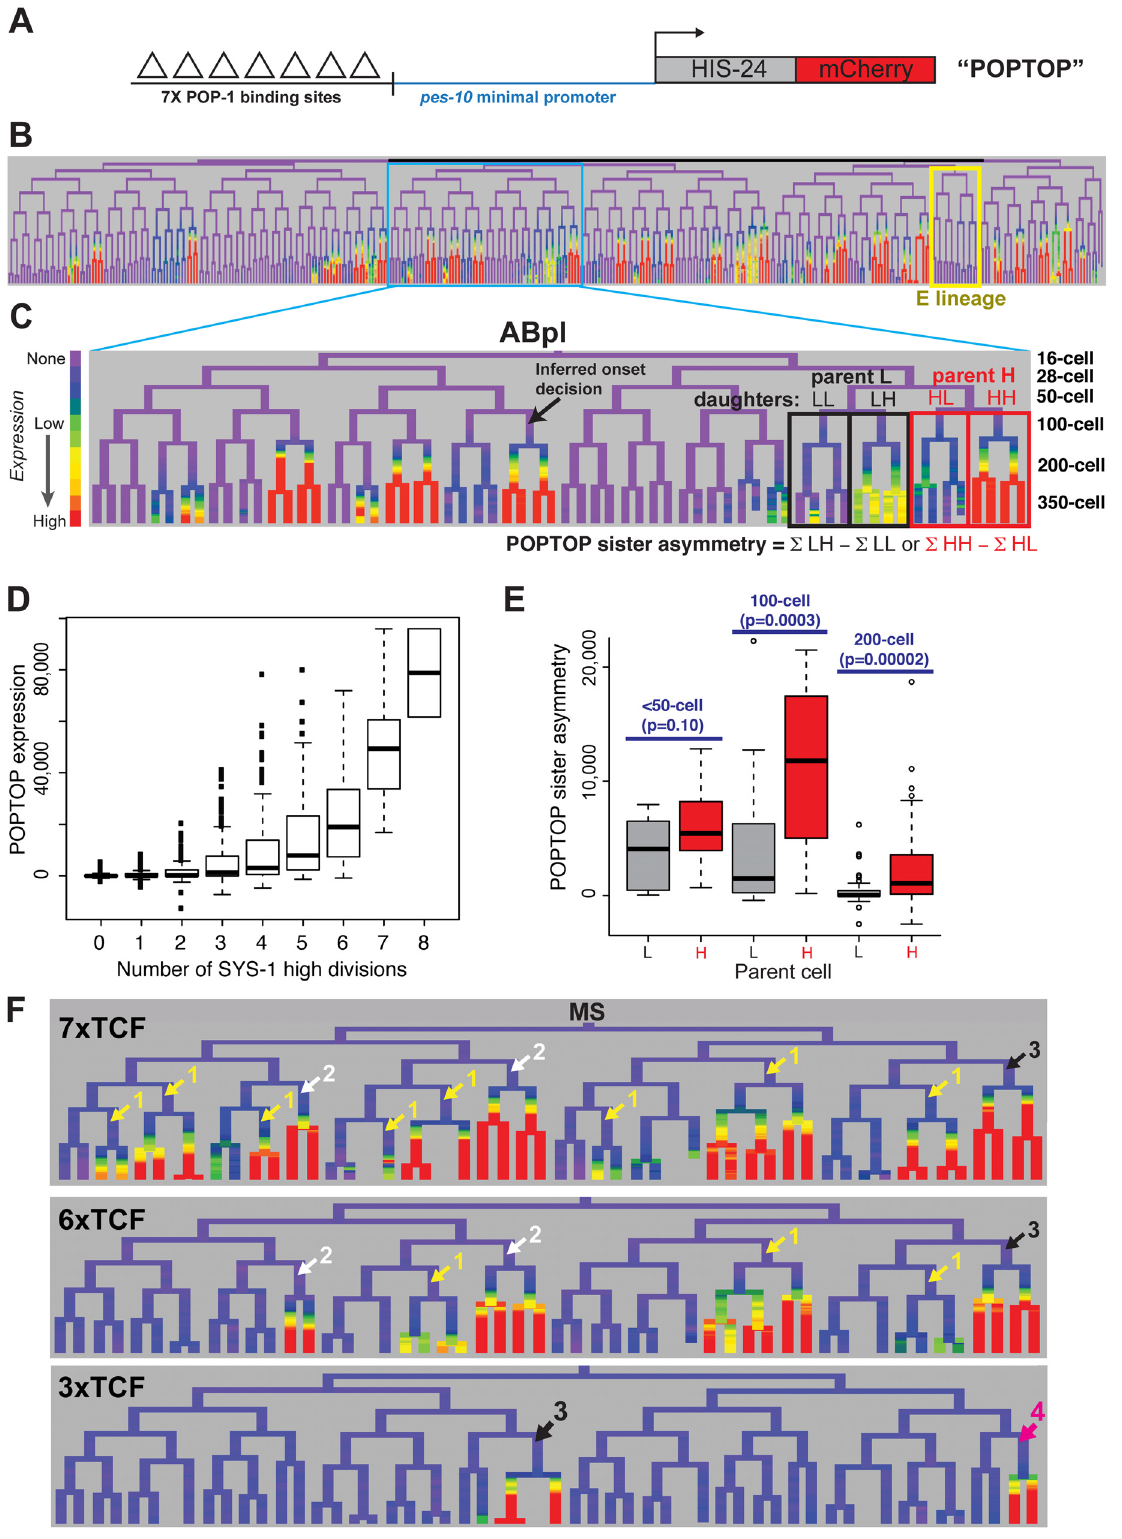
Fig 5. A reporter of POP-1-dependent activation shows stronger activity in double-posterior lineages. A) POPTOP construct [59], a minimal promoter driven by 7 TCF binding sites. B) Expression of POPTOP in the embryo. Expression is limited to descendants of posterior daughter cells (right